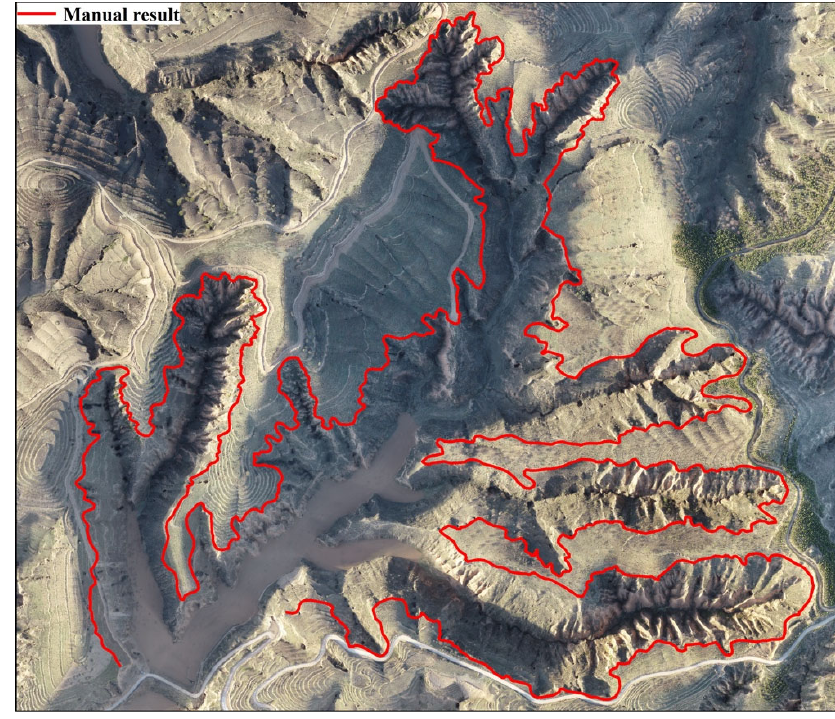
Figure 11. Manual interpretation of shoulder-line.